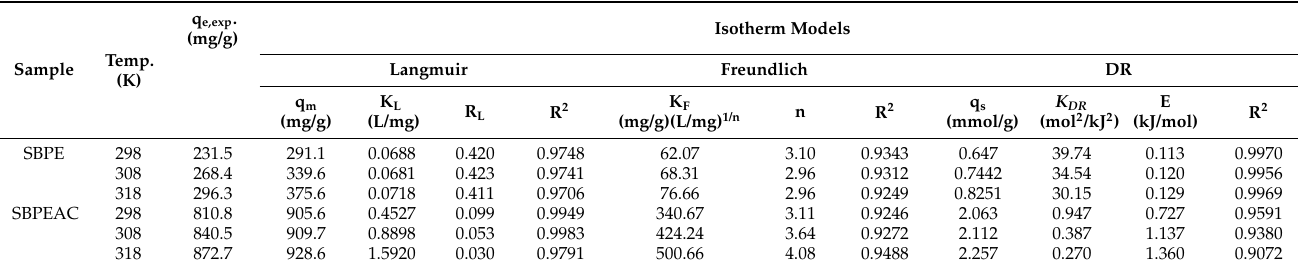
Table 2. Non-linear isotherm model parameters for MG adsorption on adsorbent samples at varied temperature.